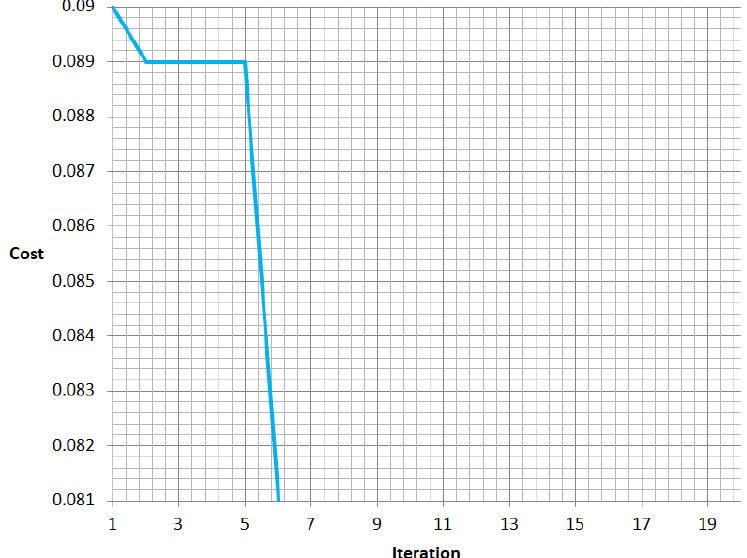
Figure 7. Convergence curve of the GA on the time series